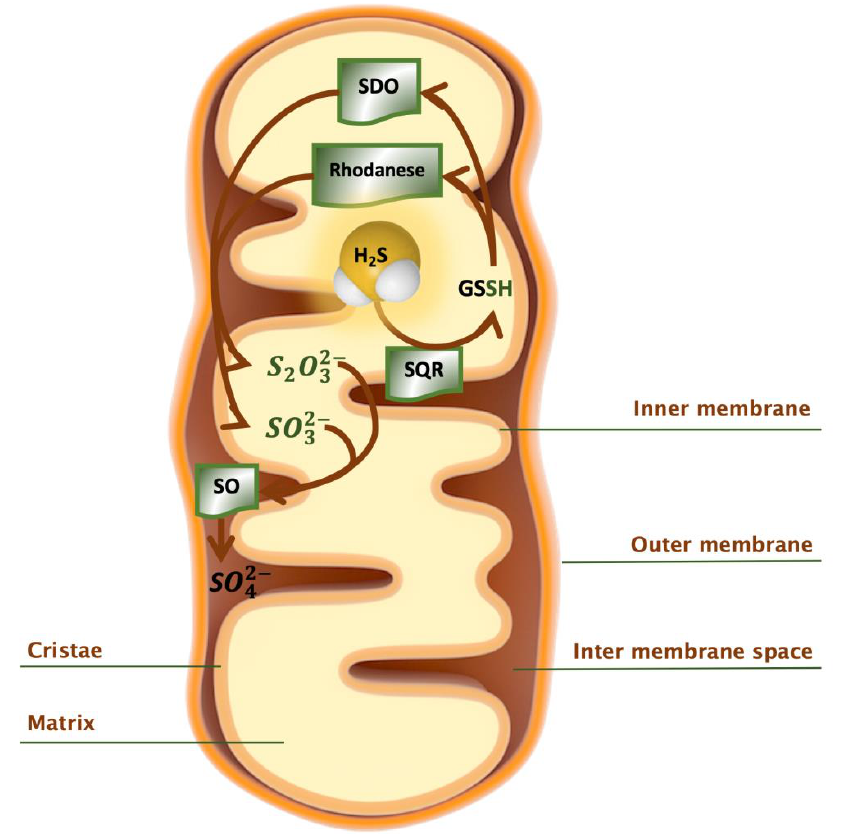
Figure 7. Oxidation pathway of H 2 S. In the mitochondrial matrix, SQR oxidizes H 2 S to GSSG and transfers the derived electrons to the respiratory chain, where they reduce coenzyme Q and drive ATP synthesis. GSSG undergoes further oxidation by SDO forming sulfite. Alternatively, rhodanese catalyzes GSSG, forming a thiosulfate anion. In the next step, the products sulfite and thiosulfate anions are oxidized to sulfate by the enzyme sulfite oxidase. (SQR = sulfide quinone oxidoreductase, SDO = persulfide dioxygenase, SO = sulfite oxidase, GSSH = glutathione persulfide). Modified from Libiad et al. [65].